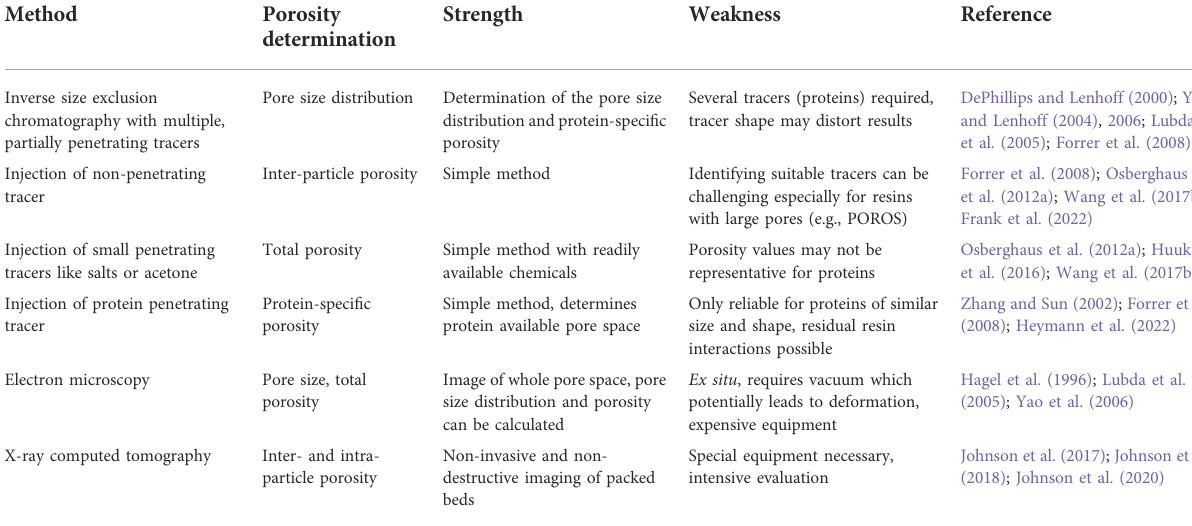
TABLE 2 Methods described in the literature for the determination of different column